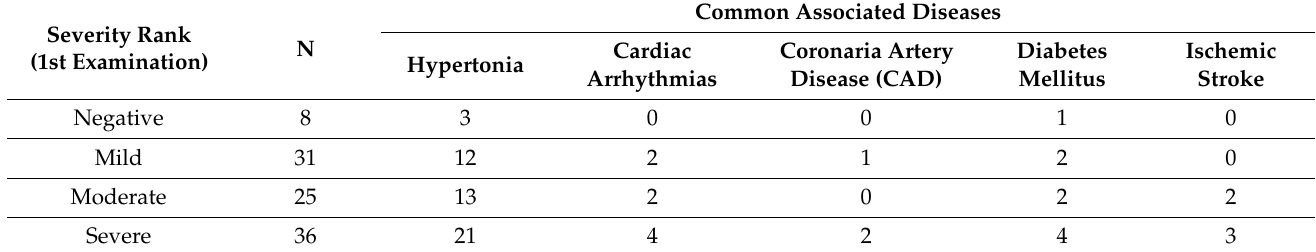
Table 7. The disease profile of the participants sorted by severity group based on the categorization of the first polygraphic